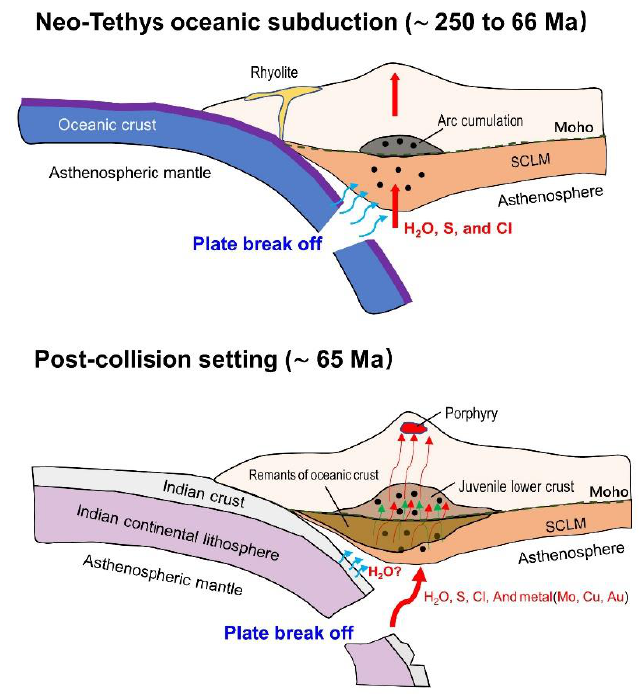
Figure 12. Schematic diagram showing the genetic and geodynamic model for the Miocene high-K felsic intrusion in Demingding porphyry Mo (Cu) deposit in Tibet.